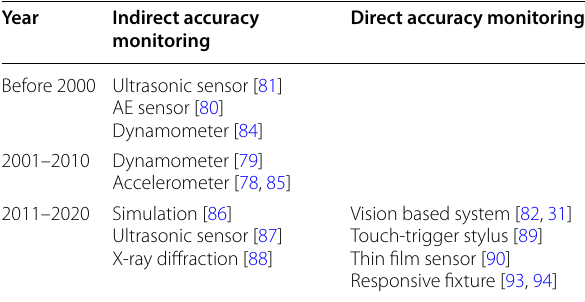
Table 4 Evolution of workpiece condition monitoring Year Indirect accuracy Direct accuracy monitoring